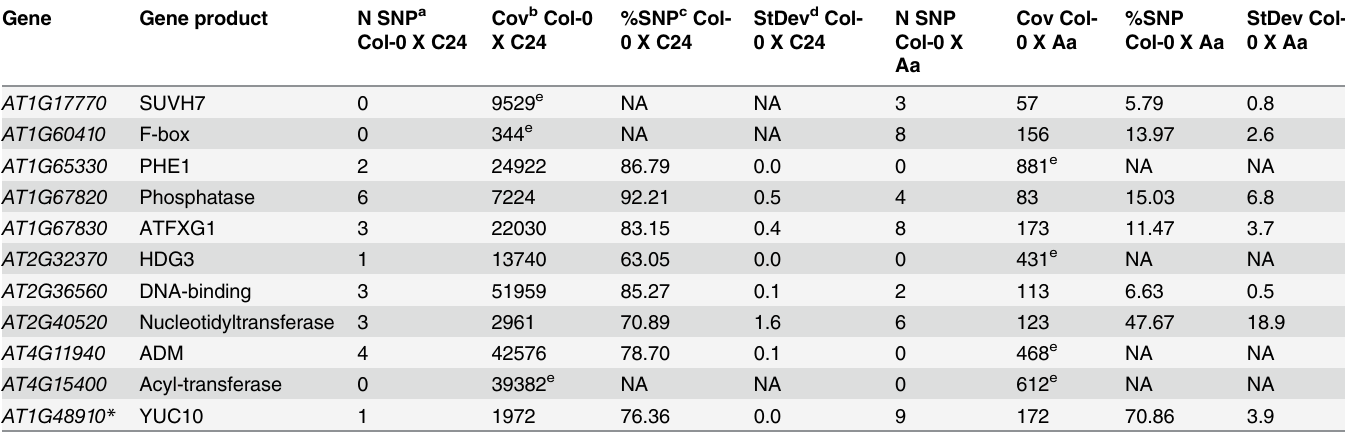
Table 3. Validation of Paternally Expressed Genes (PEGs) misexpression. Gene Gene